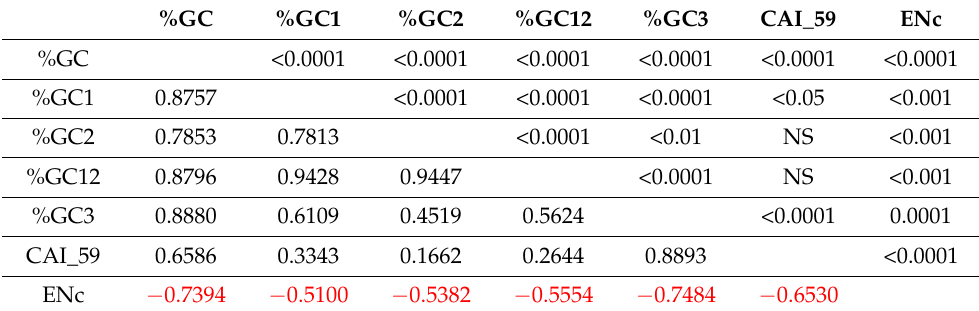
The red color font shows the negative correlation and black colored font shows positive correlation.